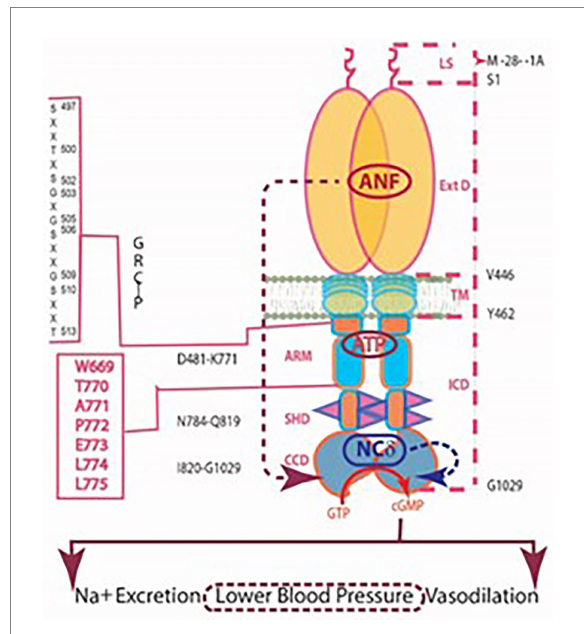
FIGURE 8 Independent signaling pathways of ANF/ATP and of NC δ . The trajectory of the ANF pathway (maroon dashed arrow) originates at the ExtD and passes through the TM, ARM and signaling helix domain (SHD) in its course to CCD. In contrast, the trajectory of the NC δ pathway (blue dashed arrow) lies within the CCD. The ANF-RGC dimer is thought to bind a dimer of NC δ , but only a single subunit is shown. Both pathways are the physiological regulators of the mouse blood